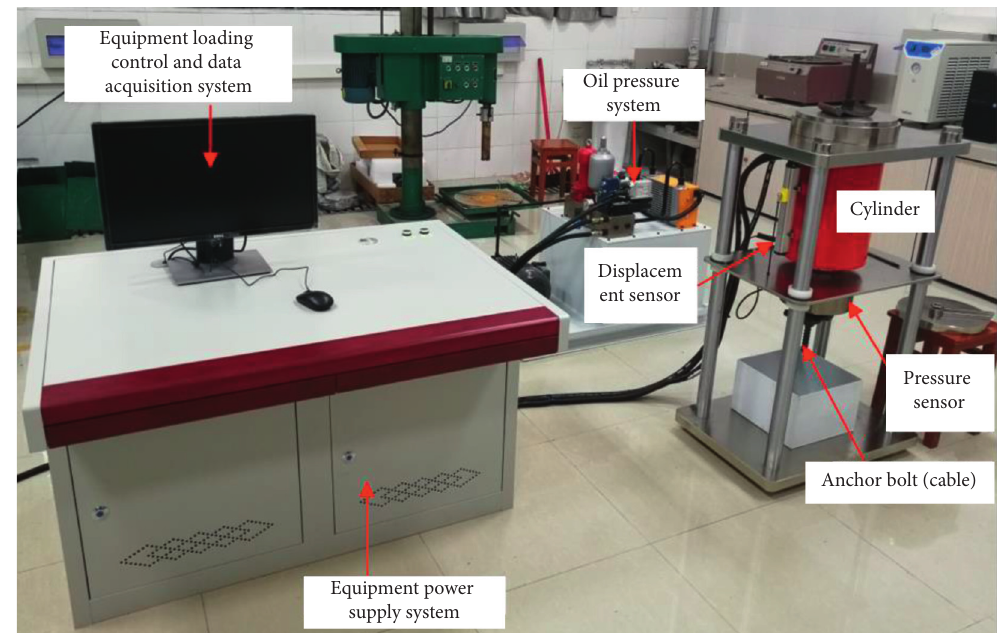
Figure 2: QKX-MLB-500 bolt (cable) pull-out creep test system.